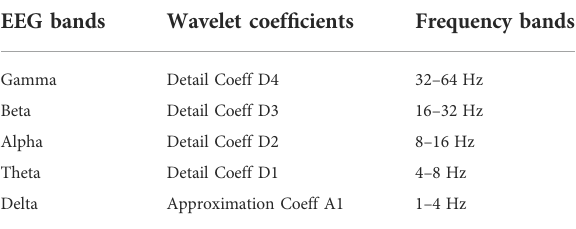
TABLE 1 Frequency bands of EEG corresponding to the wavelet coef fi cients obtained from a 4-level wavelet decomposition of band-limited